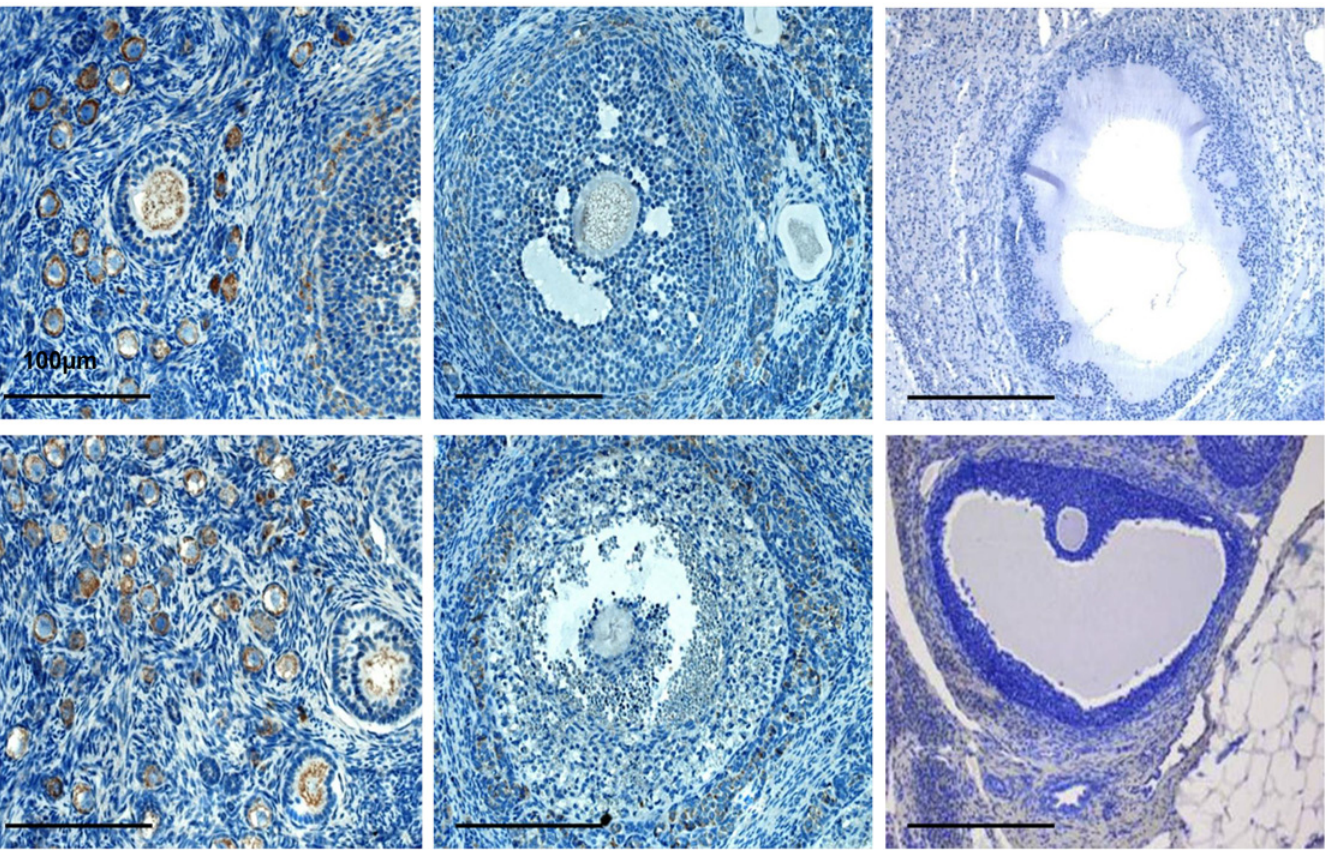
Fig 4. Immunohistochemical staining for GDF9 in the rabbit ovaries of the mothers and F1- female offspring generations. Localization of the protein GDF9 in: (a) oocytes of the primordial and primary follicles in the VHT-treated mothers ovary; (b) oocytes and granulosa cells of the early antral follicle in theVHT- treated mothers ovary; (c) antral follicle- negative control of antibody; (d) oocytes of primary and primordial follicles in the ovary of F1 offspring born to treated mothers; (e) oocyte and cumulus-granulosa cells of the antral follicle in the ovary of F1 offspring born to treated mothers; (f) mouse ovary — positive control of antibody; (g) Original magnification: (a – f) ×